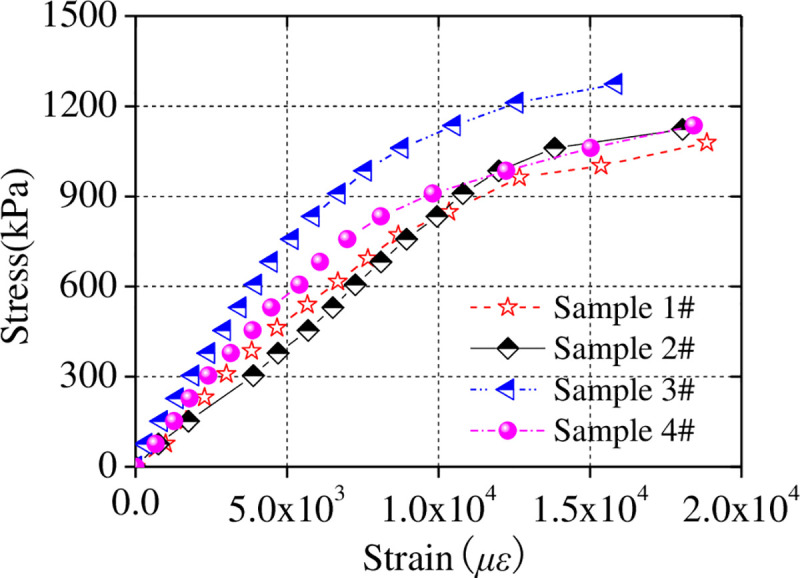
Stress-strain data.